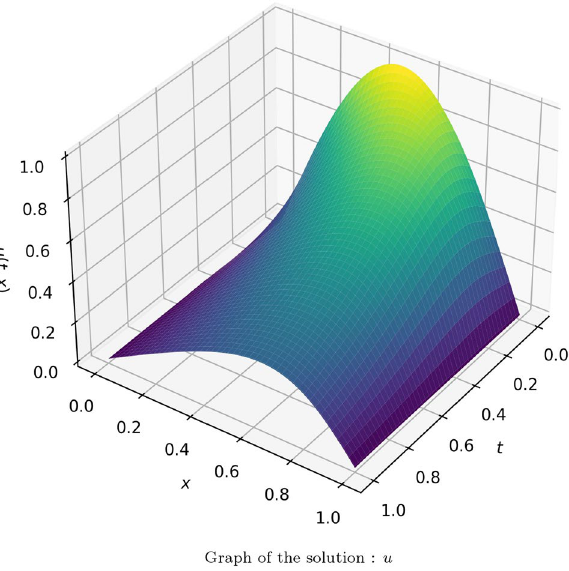
Figure 12. Solution obtained for the Burger’s equation (case 1) using the proposed method with Gaussian wavelet.